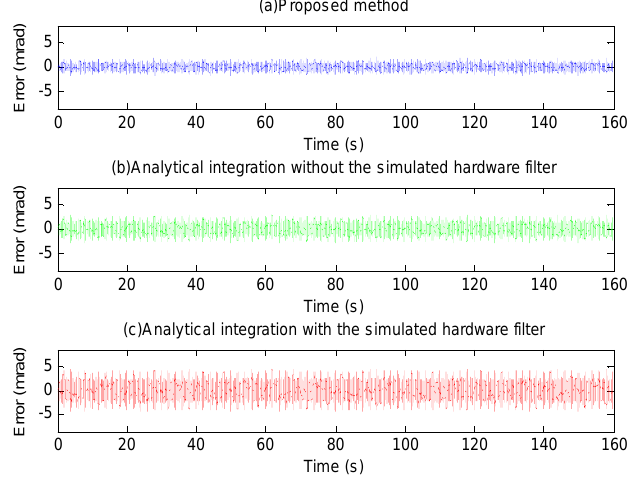
Figure 13. Orientation estimation error obtained with the proposed method ( a ), the analytical integration without the simulated hardware filter ( b ), and the analytical integration with the filter ( c ).